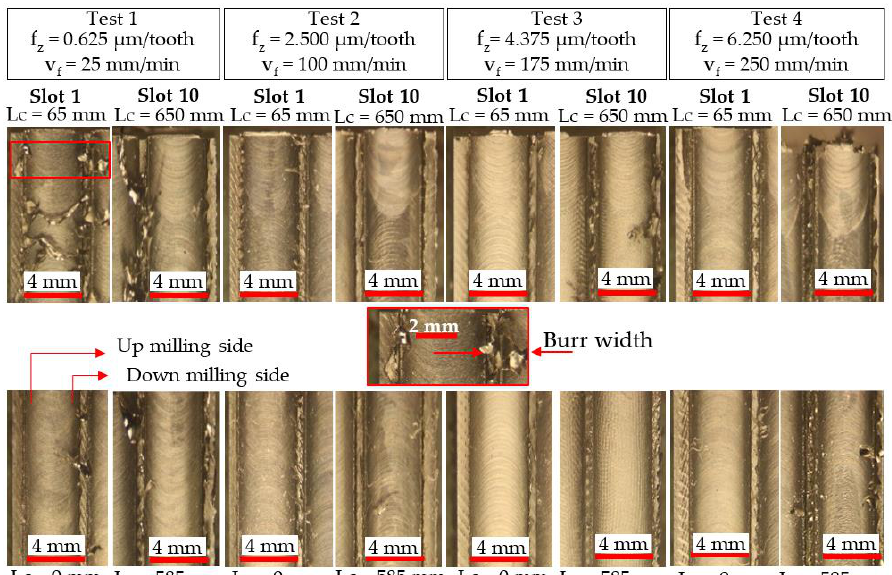
Figure 15. Optical micrographs of burr formation on the first and last slots machined using Ø 4 mm end-mills.